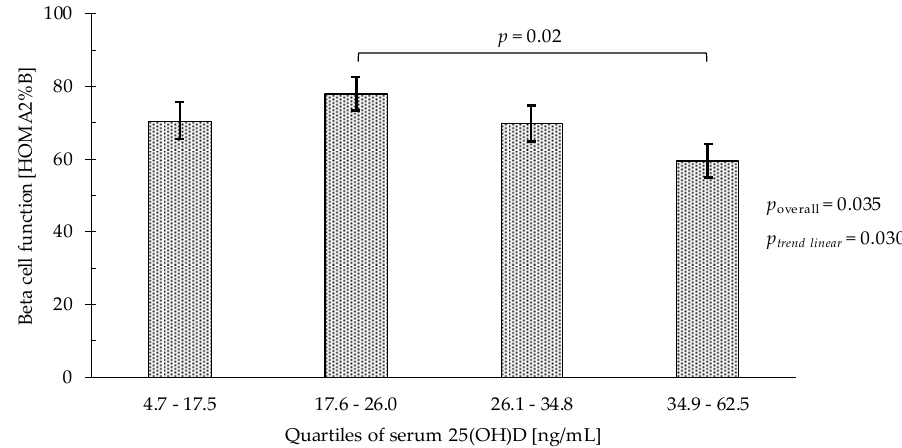
Quartiles of serum 25(OH)D [ng/mL] Figure 2. Beta cell function (HOMA2%B) by serum 25(OH)D quartiles ( n = 256), 1 ng/mL 25-hydroxyvitamin D being equivalent to 0.4 nmol/L. Bars represent least-square means (with whisker for standard error) from multivariable linear regression models. Models were adjusted for age, sex, MVPA, smoking status (non, past, and current smoker) and body mass index. 25(OH)D, 25-hydroxyvitamin D; MVPA, moderate to vigorous physical activity (min/day).